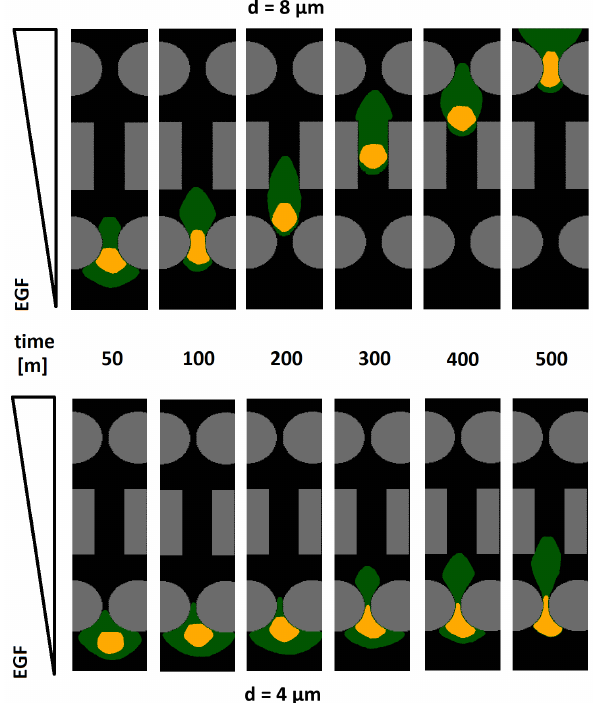
Figure 3. Simulation image sequences of the cell invading the virtual migratory channel in the representative cases d = 8 µ m (top panels) and d = 4 µ m (bottom panels), d being the distance between each pair of round pillars. We remark that, for d = 8 µ m, the cell was able to fully invade the microfluidic structure in only ∼ 30% of cases, while for d = 4 µ m, this never happened (cf. Figure 2). We remark that the initial diameter of the nucleus was d N = 14 µ